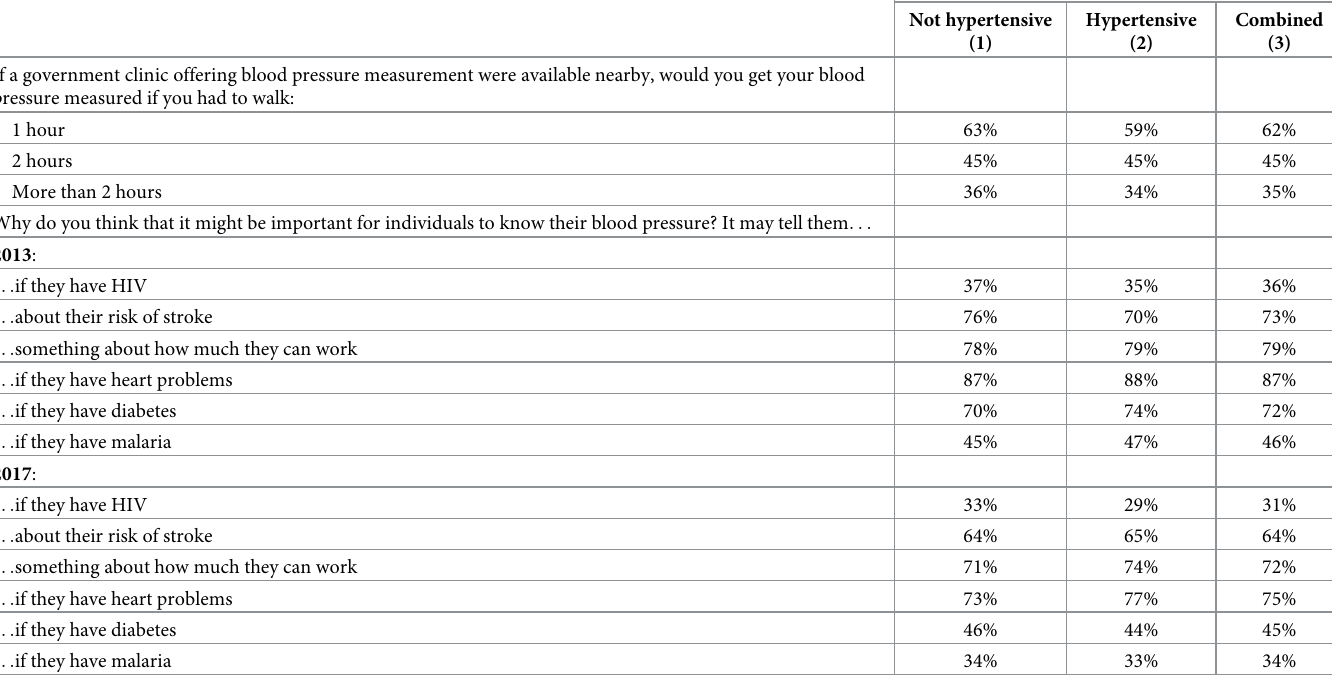
Table 5. Awareness of hypertension and knowledge of the risks associated with high blood pressure in MLSFH-MAC cohort with 2013 and 2017 blood pressure